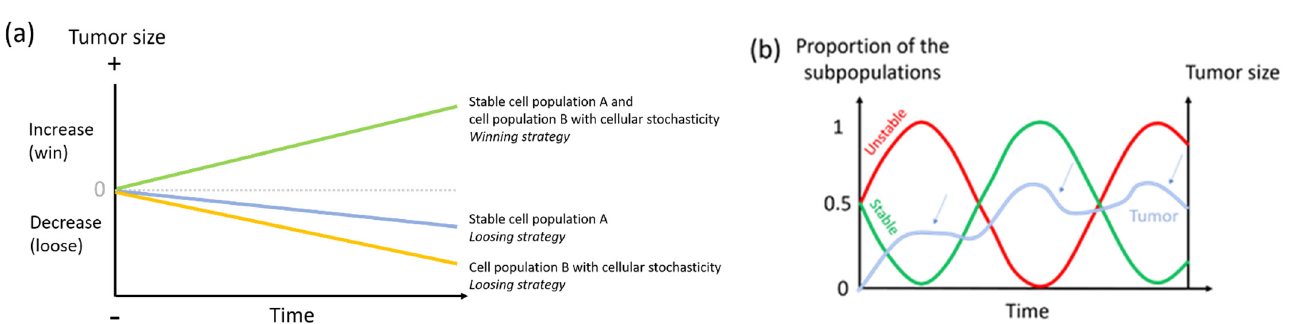
Figure 2. Hypothetical dynamics illustrating that ( a ) the co-existence of relatively stable cell populations and cell populations exhibiting stochasticity rely on the Parrondo’s paradox (adapted from [34]), ( b ) the co-existence of a relatively stable cell subpopulation (game A) and a cell subpopulation exhibiting stochasticity (game B) is necessary for tumoral growth (i.e., relying on Parrondo’s paradox). Tumor growth is impaired when the size of one subpopulation exceeds (or goes below) an optimal threshold of representation. The slope of the decrease depends on which unique strategy is overrepresented (small arrows). Also, the optimal ratio between the two strategies may vary during tumorigenesis, explaining the different slopes for the same ratios at different